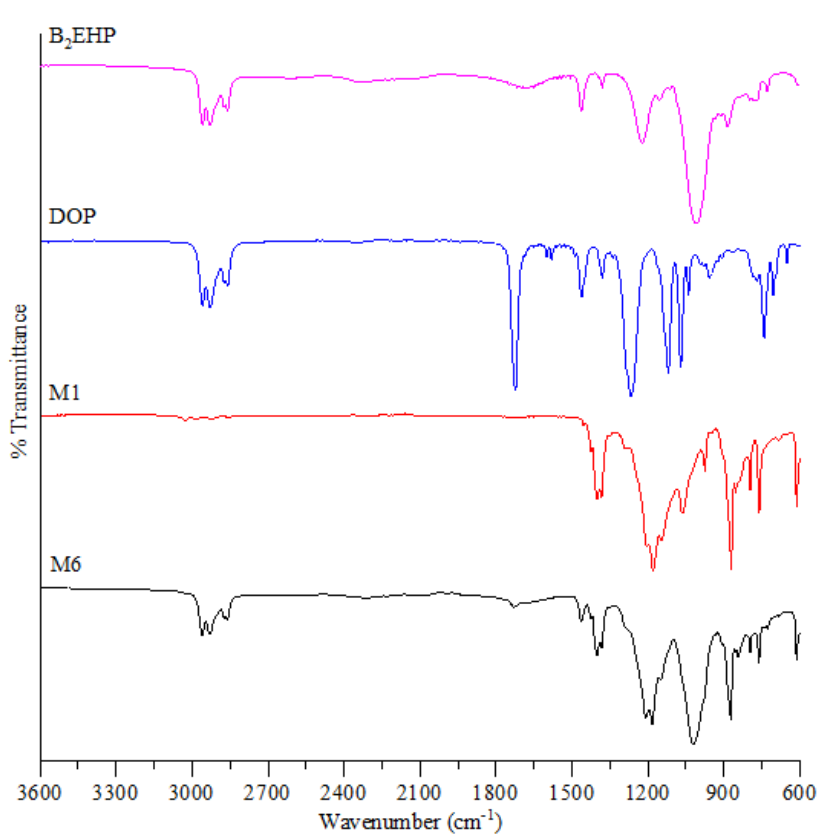
Figure 7. FTIR spectrum analysis on B 2 EHP, DOP, M1 and M6. Table 5. The values of the wavenumbers (cm − 1 ) and some significant peaks in the FTIR spectra of the pure B 2 EHP, pure DOP and membranes (M1 and